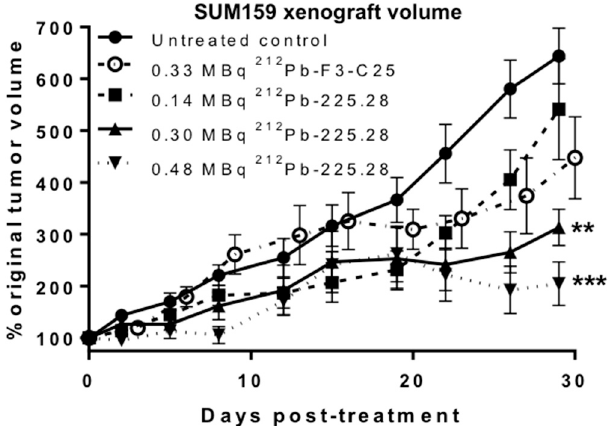
Figure 4. In vivo tumor growth curves showing the effects of 212 Pb-225.28 or 212 Pb-F3-C25 on human TNBC xenograft growth inhibition. Groups of mice ( n = 10/group) bearing small SUM159 tumors either were left untreated (filled circles) or injected i.v. with 0.33 MBq 212 Pb-F3-C25 (open circles) or with 0.14 MBq (filled squares), 0.30 MBq (upward triangles), or 0.48 MBq (downward triangles) 212 Pb-225.28. Data were plotted as mean percent change (±standard error of the mean) in normalized tumor volume over time relative to the initial volume at the time of injection with the RIC, and analyzed by one-way ANOVA with Bonferroni’s comparison. ** p < 0.01 or *** p < 0.001 vs. 212 Pb-F3-C25 at day 29 after dosing.